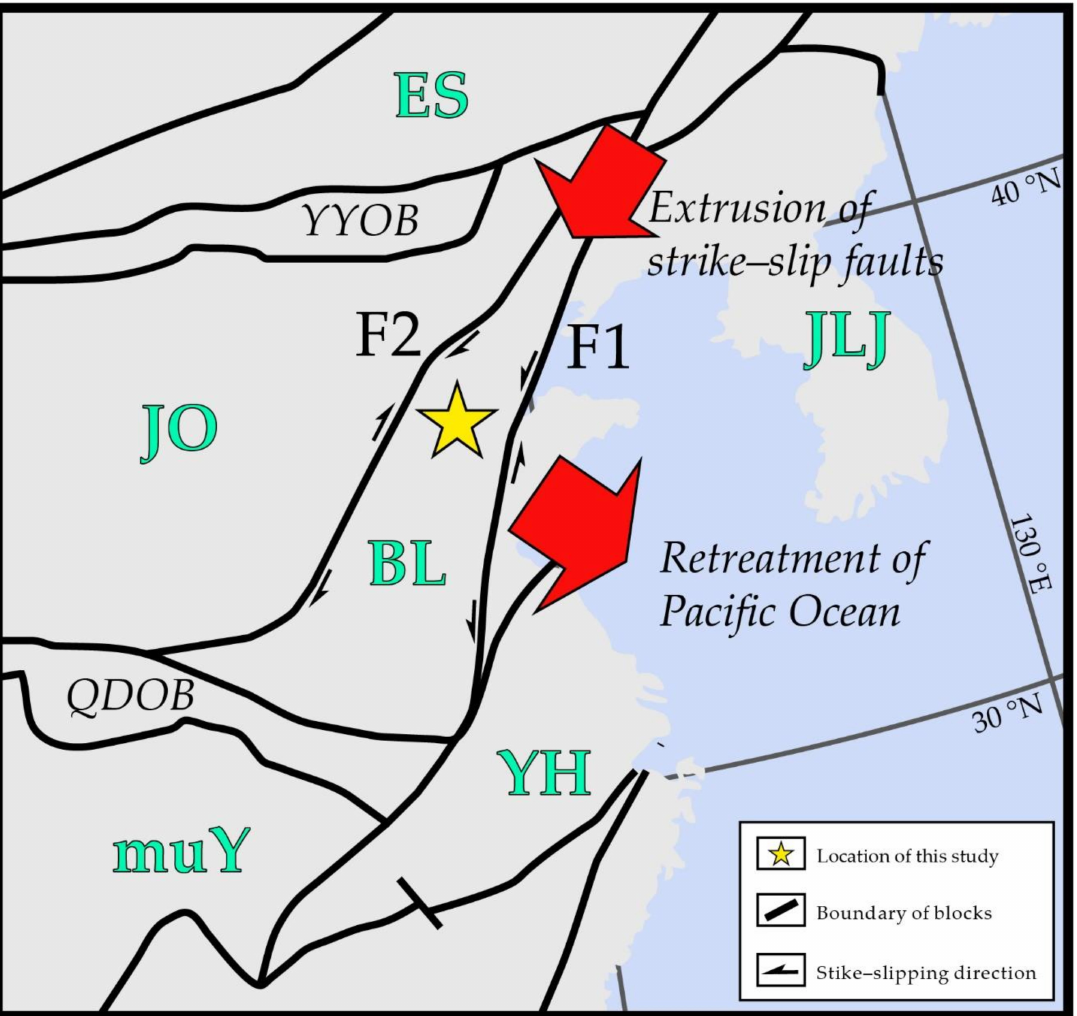
Figure 10. A simplified tectonic map of eastern China. Modified from Li et al. (2010) [89]. BL = Bohai–Luxi block; ES = Erlian–Songliao block; JLJ = Jiaobei–Liaodong–Jinan block; JO = Jinji–Ordos block; muY = middle–upper Yangtze block; YH = lower Yangtze–southern Huanghai block; YYOB = Yinshan–Yanshan orogenic belt; QDOB = Qinling–Dabie orogenic belt; F1 = Tan–Lu strike-slip fault; F2 = Lan–Liao strike-slip fault. Red arrows indicate the directions of tectonic